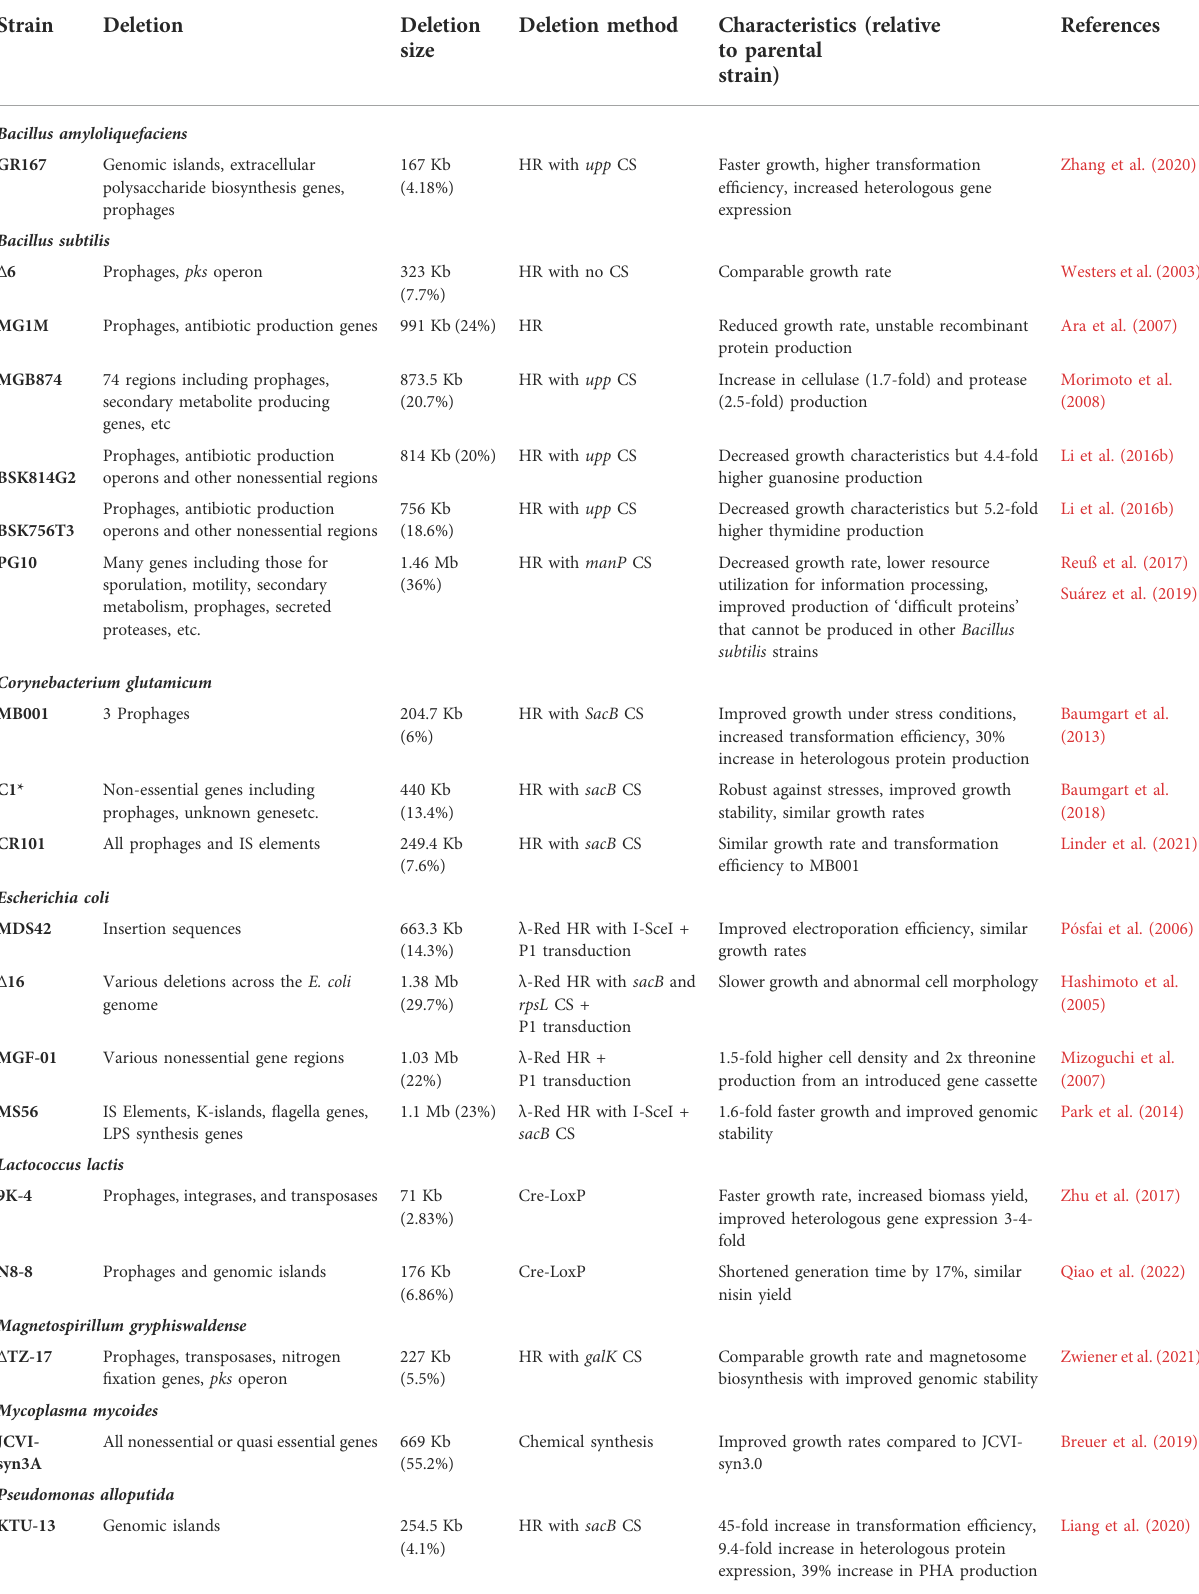
TABLE 3 Previous genome reduced bacterial